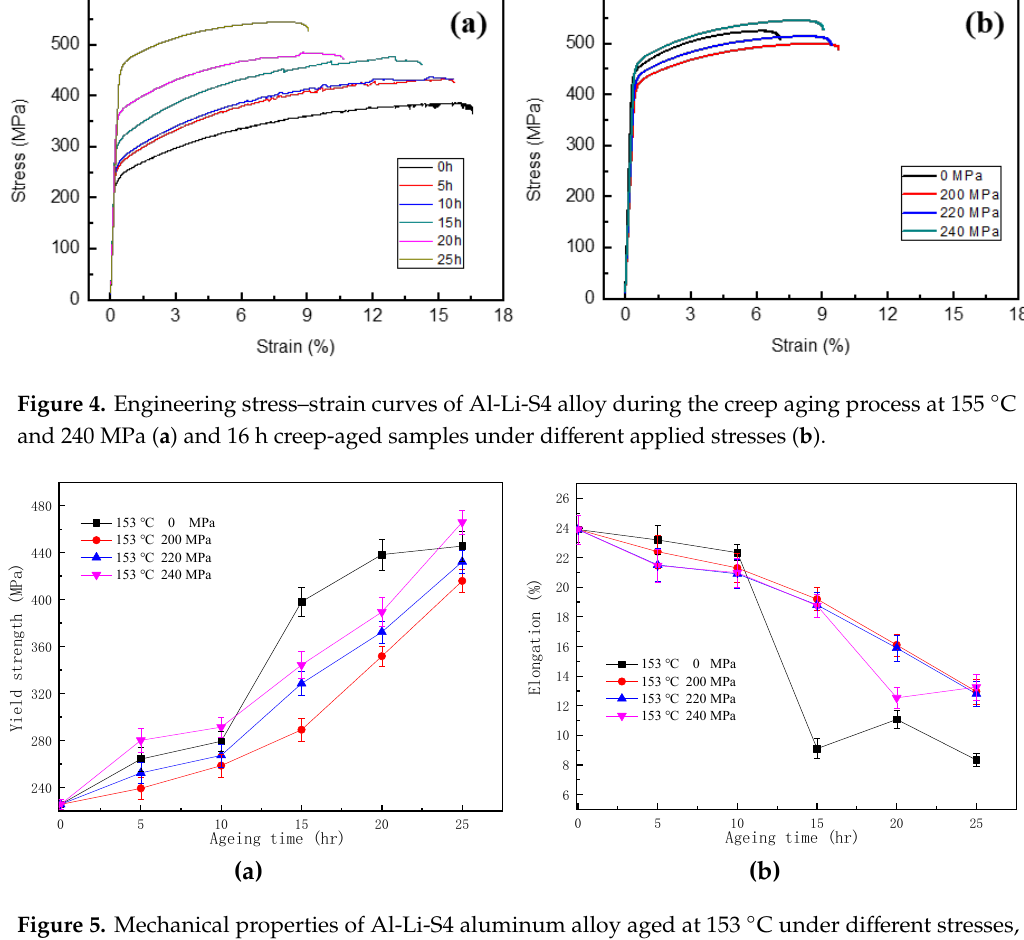
Figure 5. Mechanical properties of Al-Li-S4 aluminum alloy aged at 153 °C under different stresses, ( a ) Tensile yield strength curve, ( b ) Elongation curve.